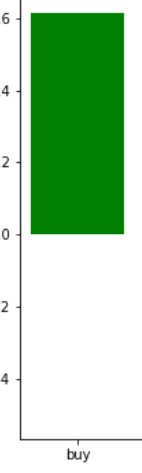
Figure 6. Facebook stock Buy and Sell